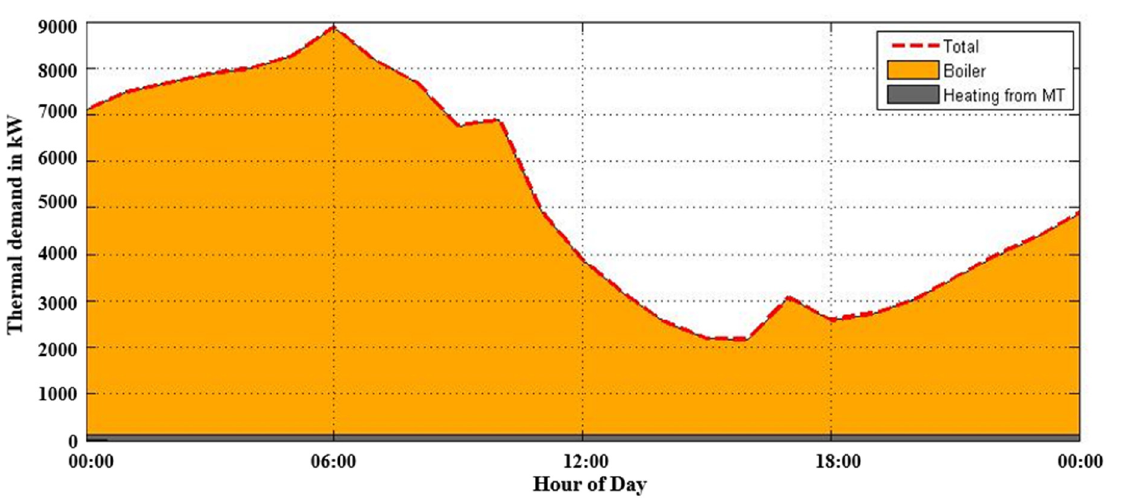
Figure 9. Electric output for optimal power for various candidate options on electrical peak day (scenario 1): ( a ) MT only electric output; 1 August 2013; ( b ) MT and PV electric output; 1 August 2013; ( c ) MT and FC electrical output; 1 August 2013.